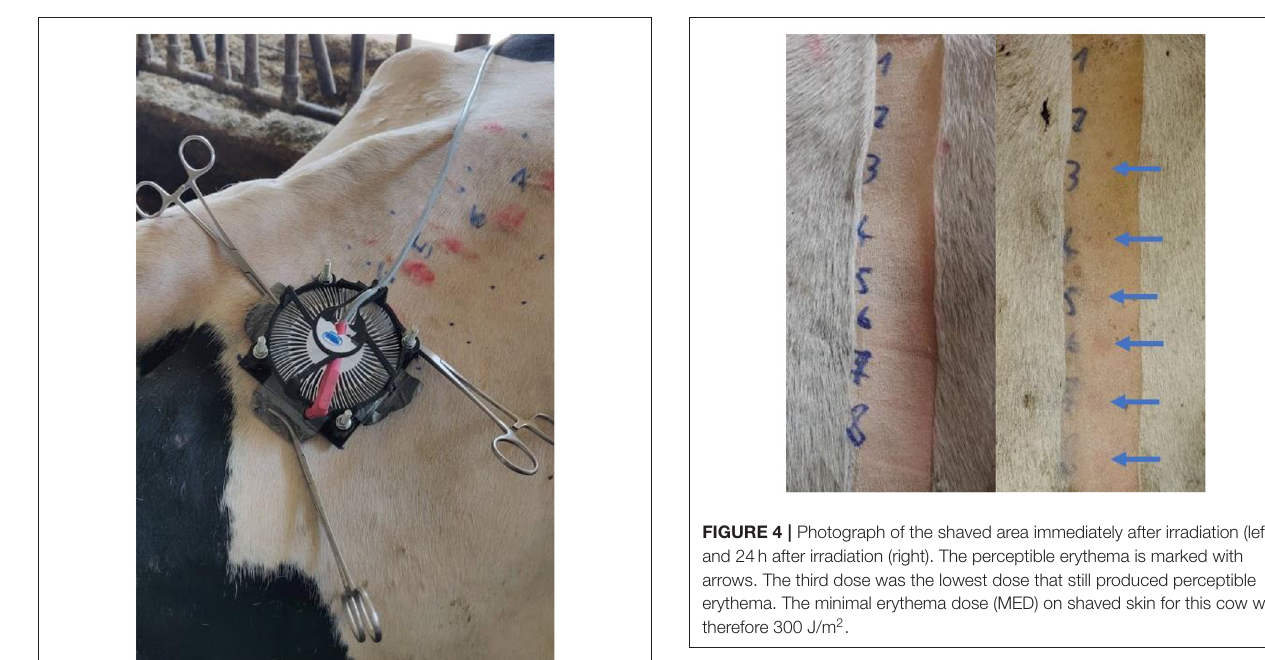
TABLE 1 | Protocol of UV light-emitting diode minimal erythema dose (MED) testing on intact-hair-covered (MED-H) and shaved (MED-S) skin using 1.48 mW/cm 2